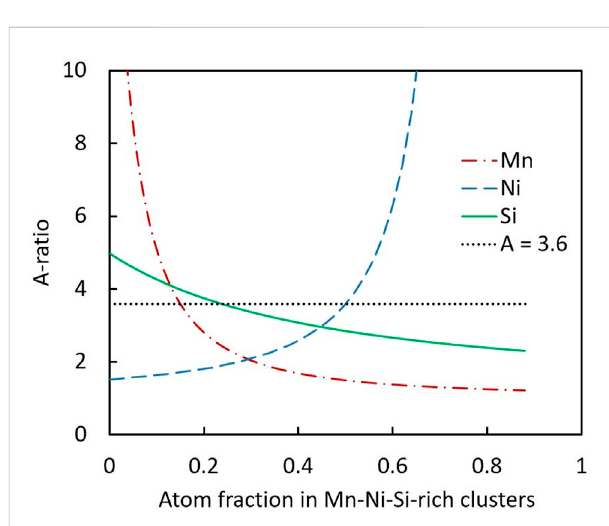
FIGURE 6 A-ratio as function of the composition of Mn-Ni-Si-rich clusters. Reference is the cluster composition reported for as-irradiated VVER- 1000 weld obeying a ratio Mn:Ni:Si = 0.15:0.50:0.24 (Miller et al., 2009). The curves correspond to the individual variation of Mn, Ni,andSiasindicated.ThereportedFe-fractionof0.11andtheratioof the remaining two elements were kept